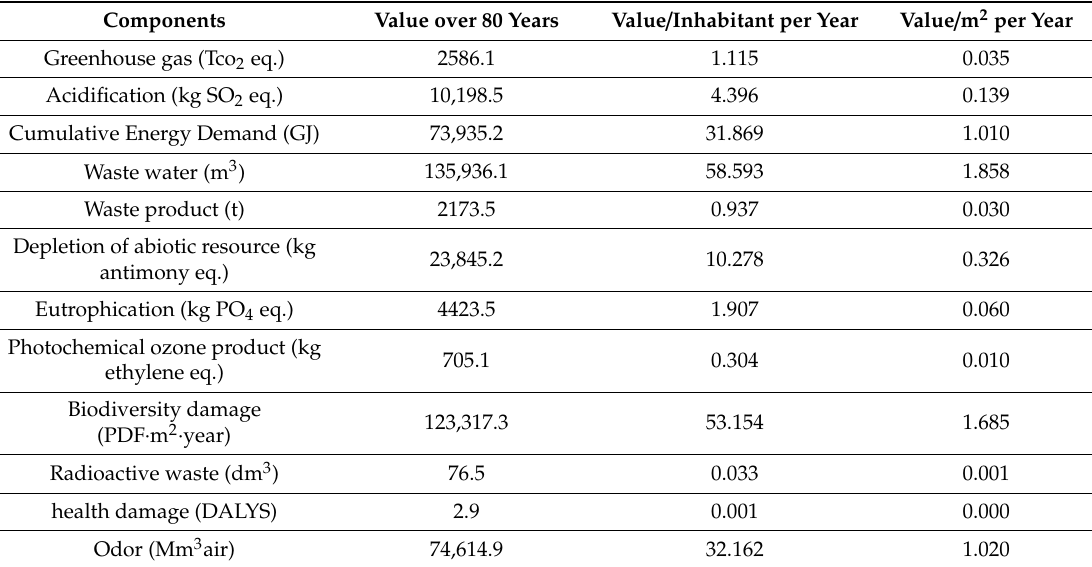
Table 4. Average LCA results for the buildings in terms of calculated